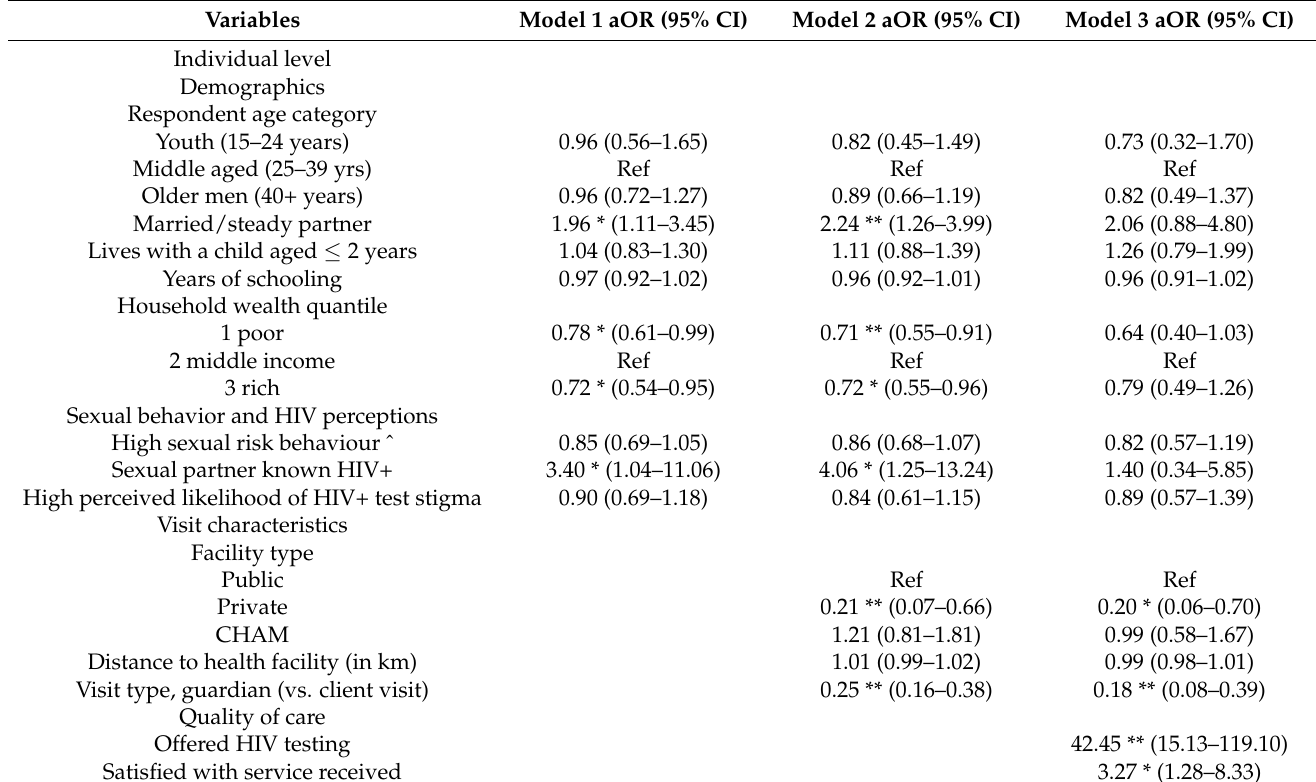
Table 3. Multivariate logistic regression of factors associated with HIV testing at an OPD